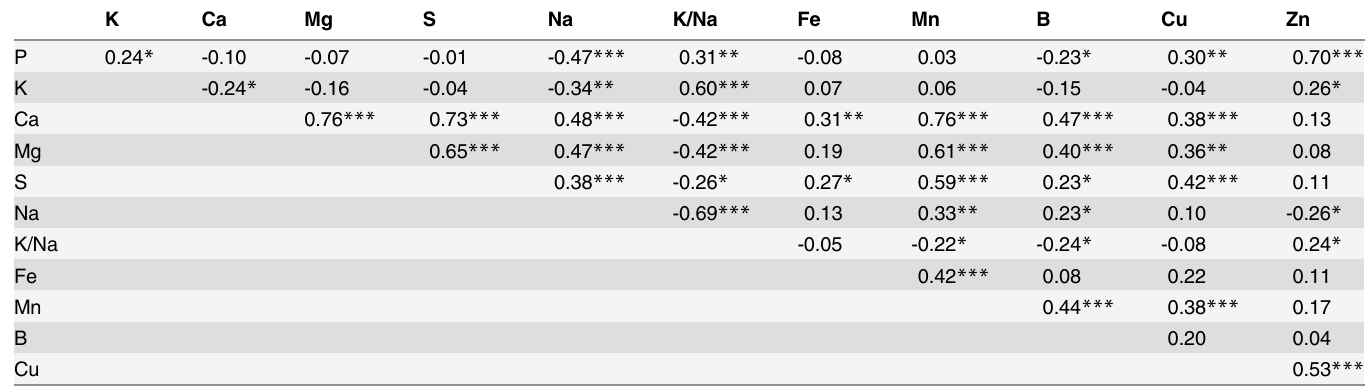
K and Ca and between S and K/Na ratio (-0.24 to -0.26, P < 0.05). The relation for K/Na ratio with macronutrients was consistent with that for K but opposite to that of Na with macronutri- ents, as expected from its mathematical derivation. Correlation was more common between Mn, B and Cu with the macronutrients, Na and K/Na ratio except K (Table 4). Most of those correlations were positive and weak but moderate between P and Zn, Ca, Mg and S with Mn (0.59 to 0.76, P < 0.001). There were inverse correlations for B with P and K/Na ratio and also